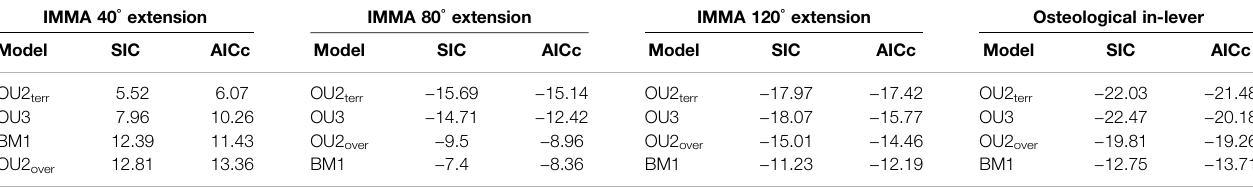
TABLE 1 | Fitted macroevolutionary models ranked according to Akaike information criterion (AICc) in ascending